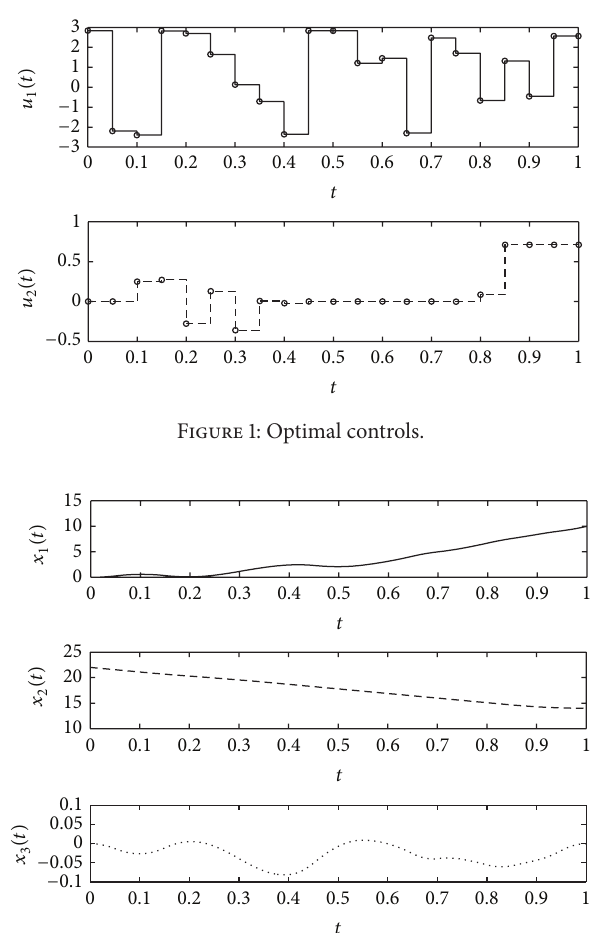
Figure 2: Optimal states under optimal